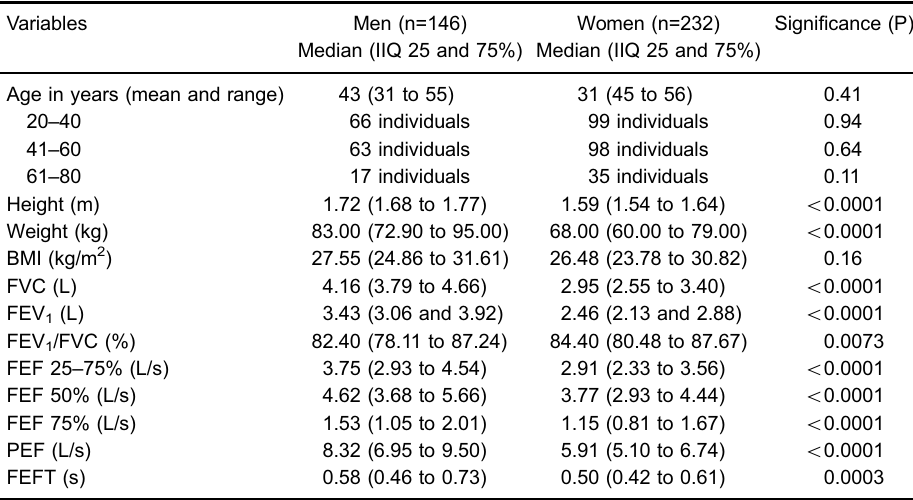
Table 1. Anthropometric and spirometric data of the healthy population included in the study. Variables